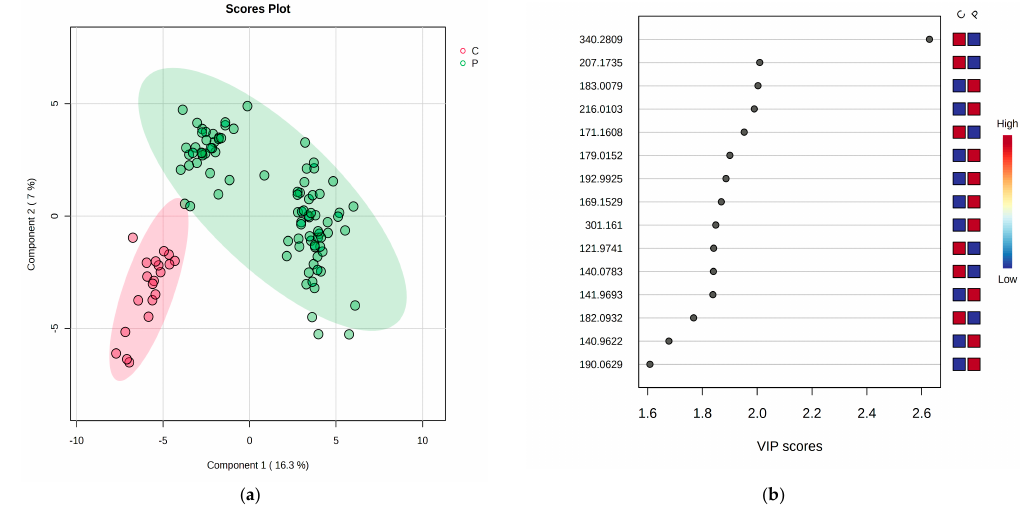
Figure 1. ( a ) The PLSDA score plot highlights the good discriminations between the C group and the CKD (P) group. ( b ) VIP values and ranking of top 15 molecules according to PLSDA analysis. According to the PLSDA plot, a division of group P into two subgroups was observed— an aspect which suggested certain molecular features which may explain this discrimination. According to VIP scores (>1.8) and MDA values (>0.004), in group P, significantly decreased molecules with m/z values of 340.2809 (Oleoyl glycine), 207.1736 (Alpha-Lipoic acid), 171.1608 (Propylthiouracil), and 121.9741 (L-Cysteine) were observed, along with increased levels of molecules with m/z = 183.0079 (Sorbitol), 216.0103 (Propenoylcarnitine), 179.0162 (Cysteinyl- glycine), and 192.9925 (5-Hydroxyindoleacetic acid). Using the cross-validation algorithm, high accuracy (close to 1), high R² values (>0.5), and a significant Q2 value (>0.4) for the first four components was identified. Therefore, the model could be considered predictive. 3.1.2. Biomarker Analysis and Prediction by Random Forest Analysis According to Metaboanalyst software, the biomarker analysis included the represen- tation of the receiver operating characteristic (ROC) curve and the area under the curve (AUC). Therefore, the sensitivity vs. speci fi city of each molecule identi fi ed as a potential biomarker was evaluated. In good agreement with all previous studies, the biomarker analysis con fi rmed that molecules which can be considered biomarker candidates are the ones with the highest AUC values (>0.85). Table 2 shows the AUC value, p -value, and log2FC value for each molecule identi fi ed and the variations between group P and group C. Table 2 summarizes the data obtained and lists the most signi fi cant molecules to be considered, according to VIP and MDA values. The identi fi cation of these molecules was made considering their m/z values in the HMDB database. Table 2. The m/z values for the most signi fi cant metabolites from serum samples and their identi fi - cation according to the HMDB database. These metabolites were considered predictive given their VIP and MDA values. m/z